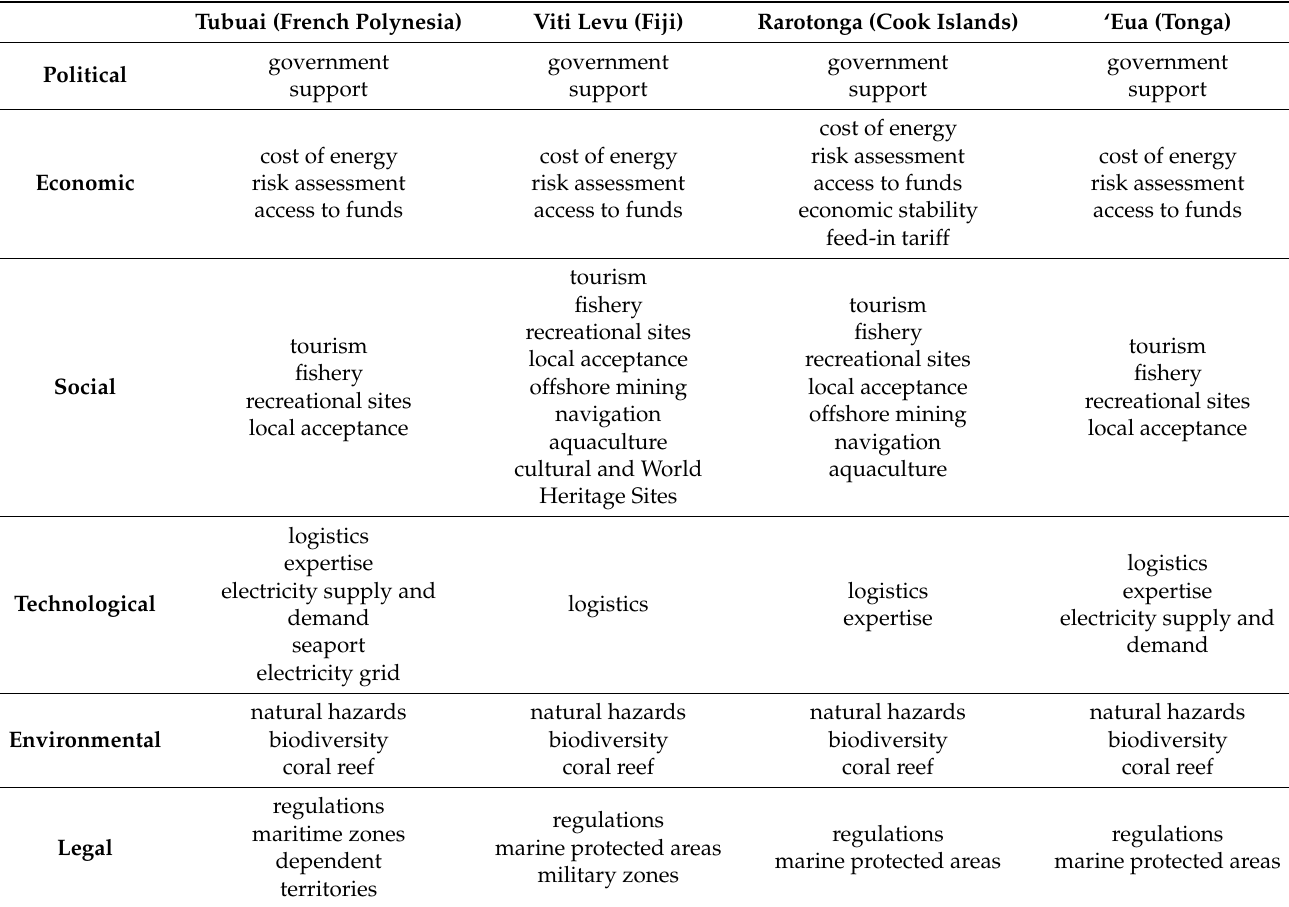
Table 2. Identified challenges for each island based on the